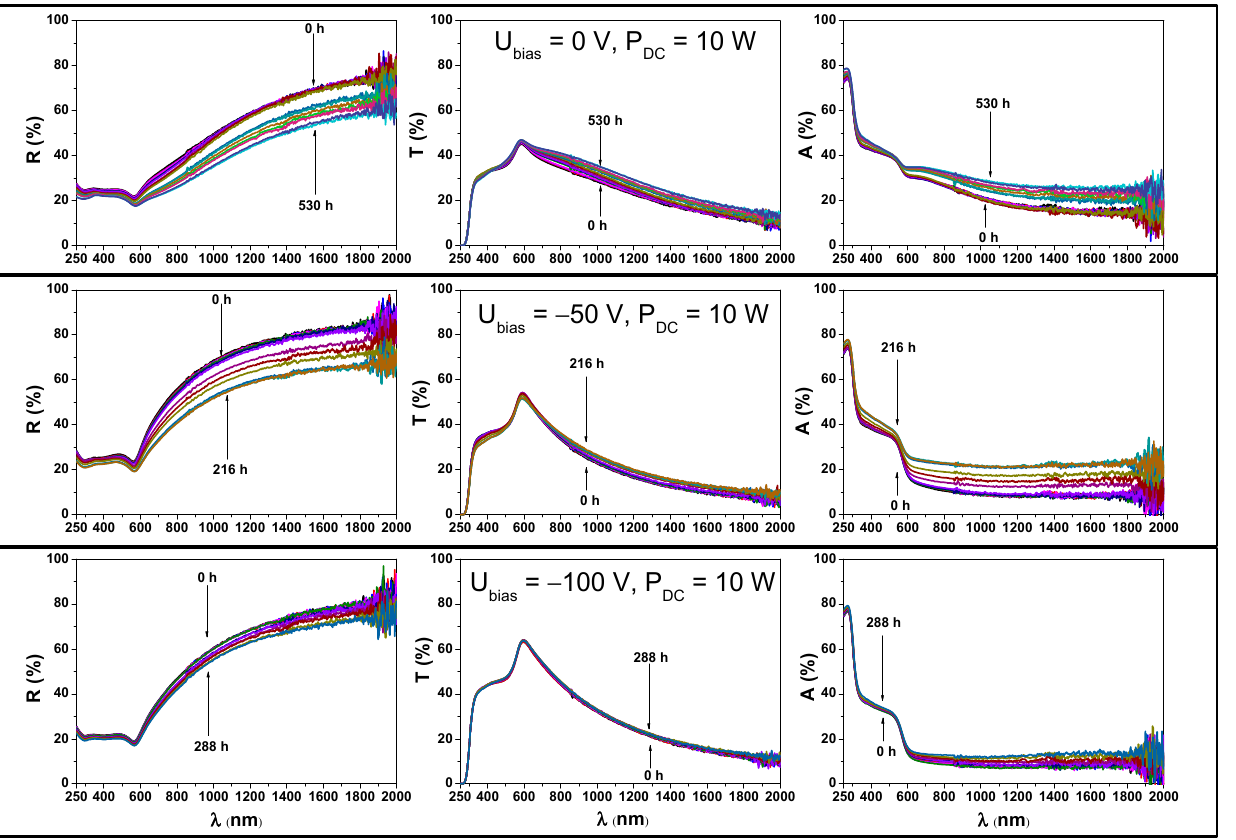
Figure 5. Experimental transmission, reflectance and absorption spectra of copper films obtained immediately after DCMS deposition process (0 h) and after several days exposure to atmospheric pressure conditions.